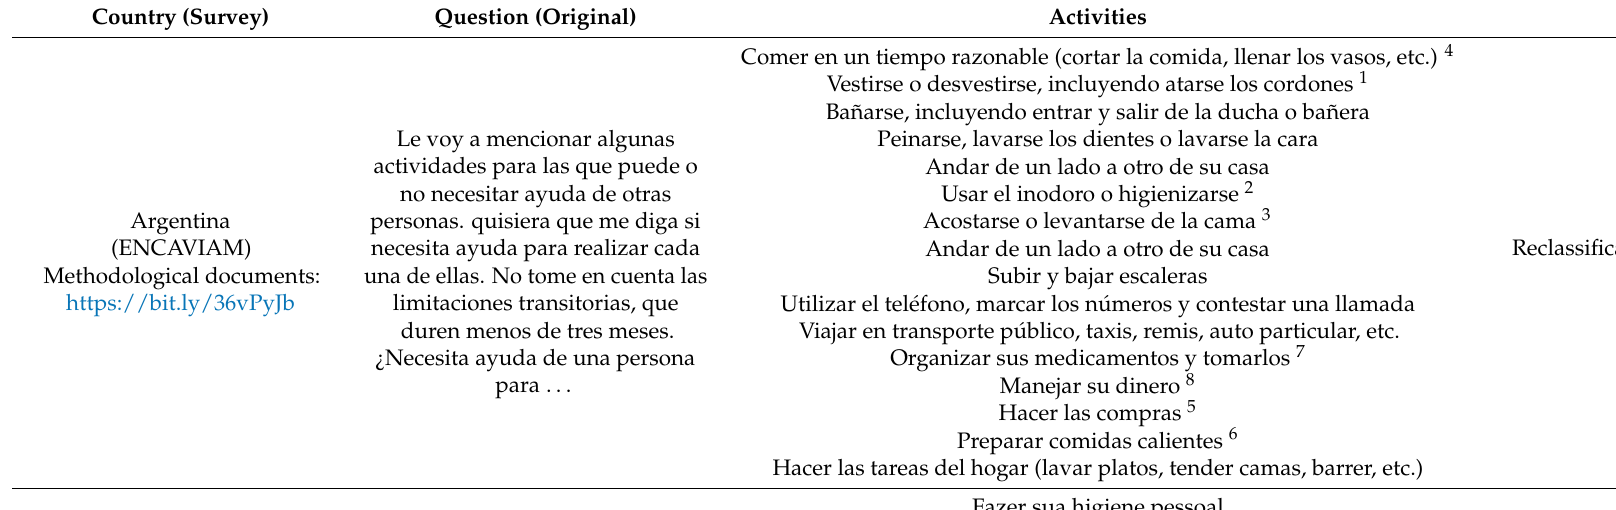
Table A1. BADL, IADL, and need of help. Original questions by survey (original